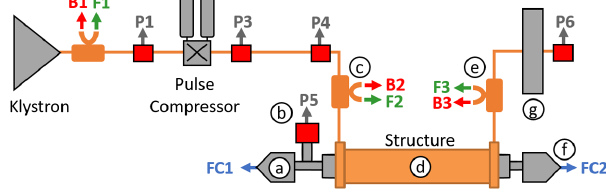
FIG. 1. Schematic of CERN ’ s XBOX2 test stand. The red and green arrows show where the backward reflected traveling wave (B) and the forward traveling wave (F) rf signals are measured via directional couplers. The upstream and downstream Faraday cup signals are labeled FC1 and FC2. The locations of the ion pumps throughout the system are also shown (P). The lowercase letters mark the items also shown in Fig. 2.